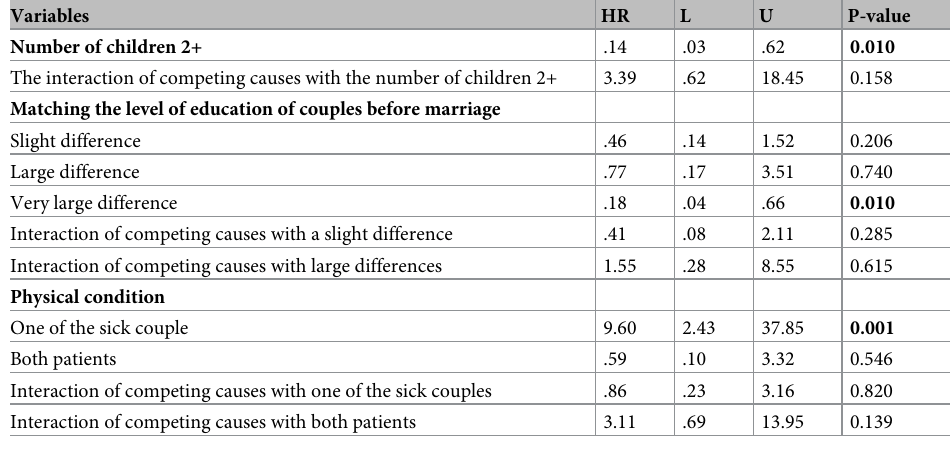
Table 5. Results of Lunn-McNeil multivariate analysis for the competing cause of family weak role in choosing a spouse. Variables HR L U P-value Physical condition One of the sick couple Both patients Matching the level of education of couples before marriage Slight difference Large difference Very large difference Interaction of competing causes with the slight difference Interaction of competing causes with large differences Interaction of competing causes with very large differences Number of children 2+ Matching the couple’s birthplace Interaction of competing causes with a similar place of birth .249 LR Chi2 (10) = 43.78, Log likelihood = -170.12572, P-Value <